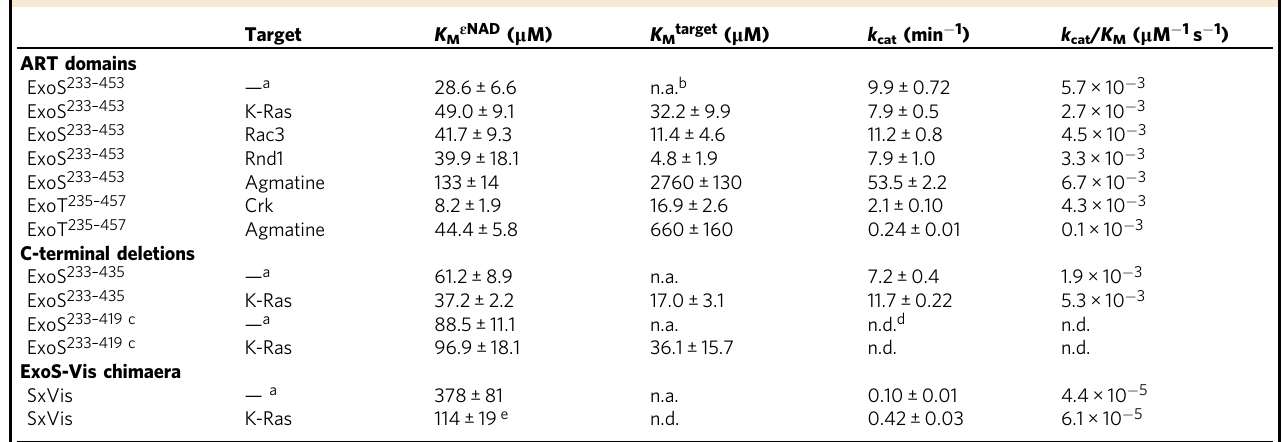
Table 2 Kinetic constants for ExoS and ExoT ADP-ribosyltransferase domain activity